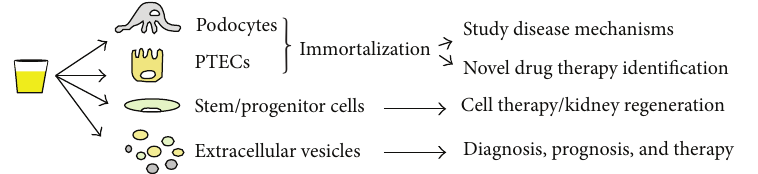
Figure 1: Urine as source of specific kidney cells and extracellular vesicles: applications and future